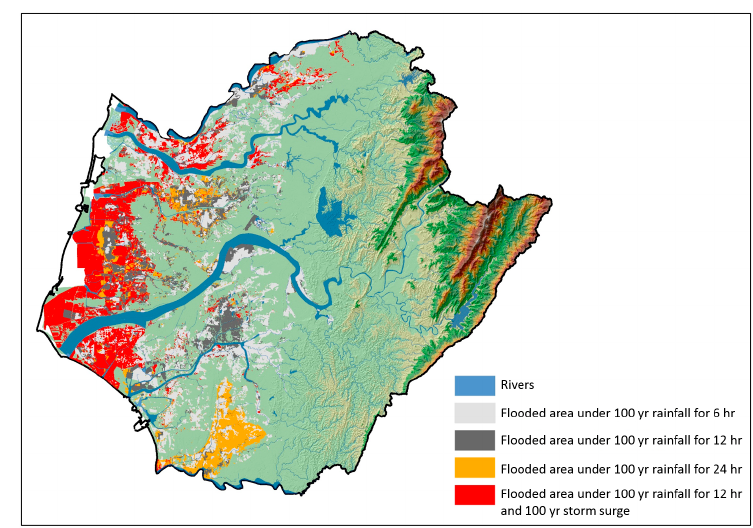
Figure 14. Overlap of the flooded area under various scenarios.